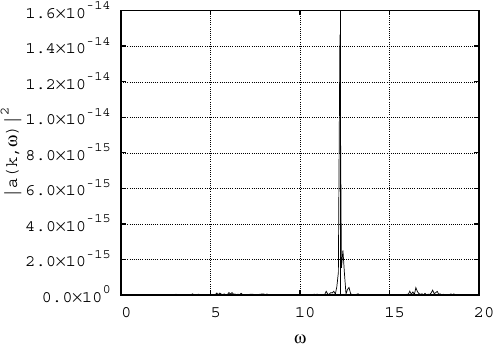
Figure 5. Spectral line of the harmonic k = (0, 150). Both the con- densate and inverse cascade were suppressed.